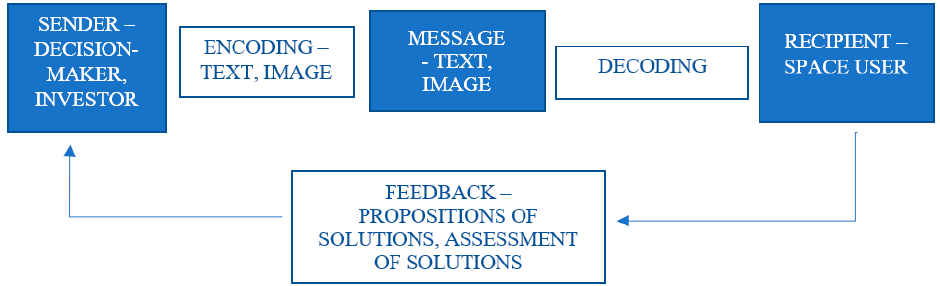
Figure 2. A diagram of communication in public consultations concerning space. Source: Prepared by the author.